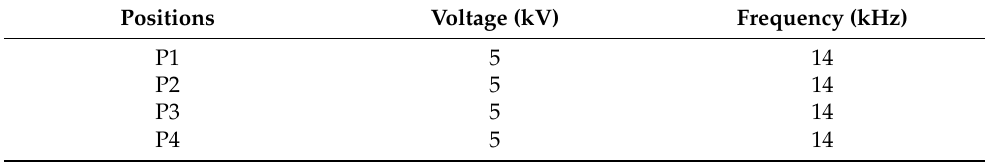
Table 7. Parameters of different actuation positions with 5 mm actuation length on inner